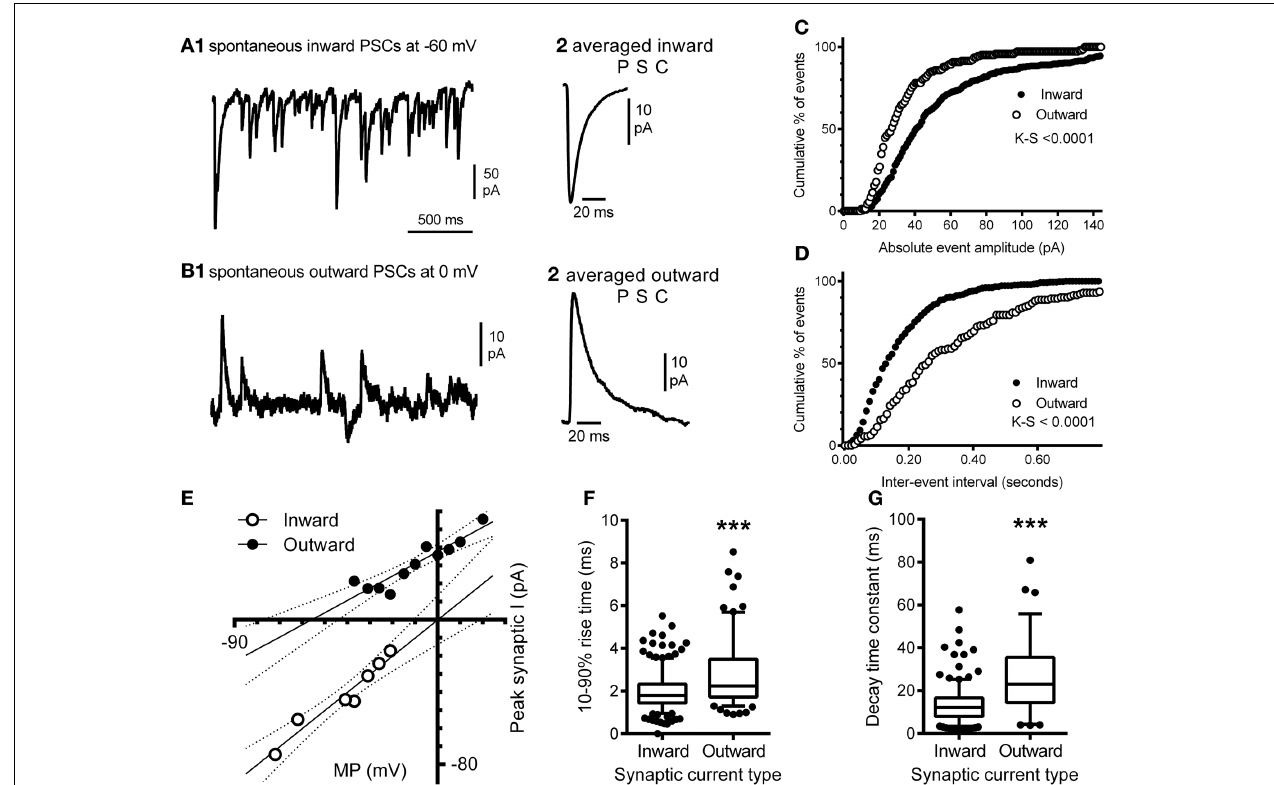
FIGURE 8 | Electrophysiological recording of inward and outward spontaneous synaptic currents shows correlation with excitatory and inhibitory synaptic labeling in hypoglossal motor neurons. Inward synaptic currents are more frequent and have a different waveform to outward synaptic currents; (A1) shows a continuous recording of spontaneous inward synaptic currents at a membrane potential of − 60mV, while (A2) shows the averaged waveform of a single inward synaptic current, with a fast 10–90% rise time and decay time. (B1) shows a continuous recording of spontaneous outward synaptic currents at a membrane potential of 0mV, from the same hypoglossal motor neuron shown in (A) , while (B2) shows the averaged waveform of a single outward synaptic current; note that the 10–90% rise time and decay time of the outward current are slower than seen in inward synaptic currents (B2) . Inward and outward synaptic currents arise from different populations of synaptic inputs to the hypoglossal motor neuron; (C) is the cumulative frequency distribution of the absolute amplitudes of all inward currents ( n = 349) at − 60mV and outward currents ( n = 142) at 0mV recorded from the same neuron; the distributions are significantly different (Kolmogorov–Smirnov test, P < 0 . 0001), while (D) is the cumulative frequency distribution of the